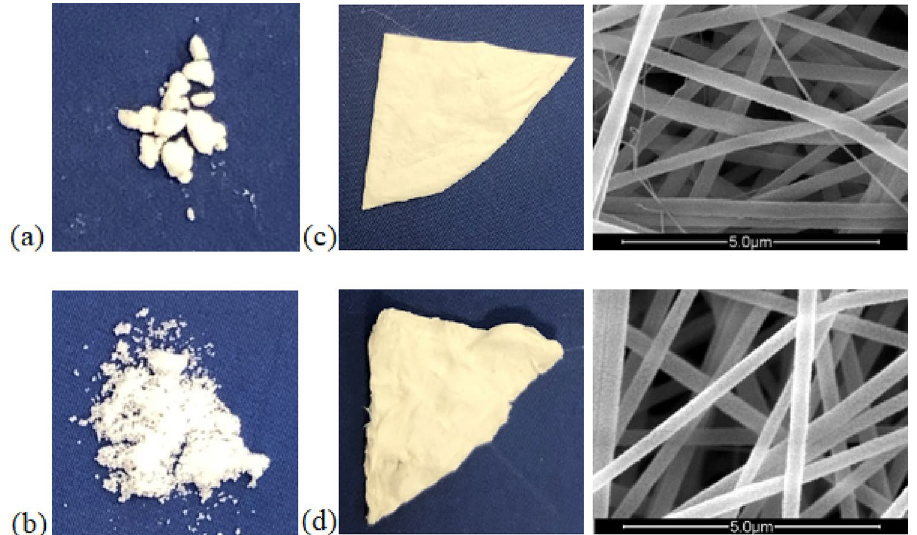
Figure 8. Photographs of ( a ) PCM28; ( b ) PCM32; photograph and SEM image of composite PAN-50PCM32 nanofiber mat ( c ) before ( d ) after 50 consecutive DSC thermal